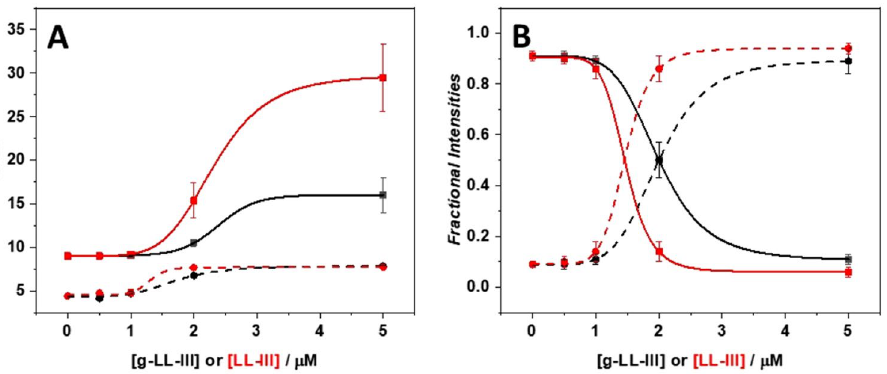
Figure 5. Fluorescence lifetimes ( A ) and fractional intensities ( B ) of DPH embedded in POPC/POPG LUVs in the absence and presence of g-LL-III and LL-III peptides, at the indicated concentrations. In panel A, squares and solid lines refer to τ 1 , while circles and dashed lines refer to τ 2 . In panel B, squares and solid lines refer to f 1 , while circles and dashed lines refer to f 2 . Experimental data referring to g-LL-III and LL-III are reported in black and red, respectively. Lines are a guide for the eyes,